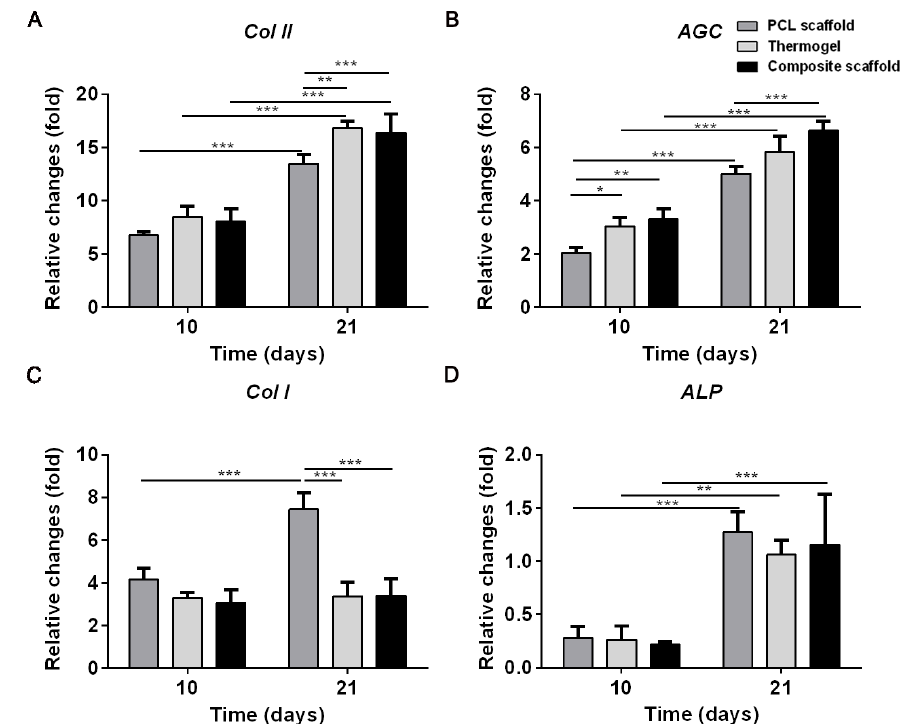
Figure 5. Expression of cartilage-specific genes of Col II ( A ) and AGC ( B ), fibrous-cartilage gene of Col I ( C ), and the osteogenesis marker gene of ALP ( D ) of BMMSCs within various scaffolds. Results are expressed as mean ˘ SD ( n = 3; * p < 0.05, ** p < 0.01, *** p <